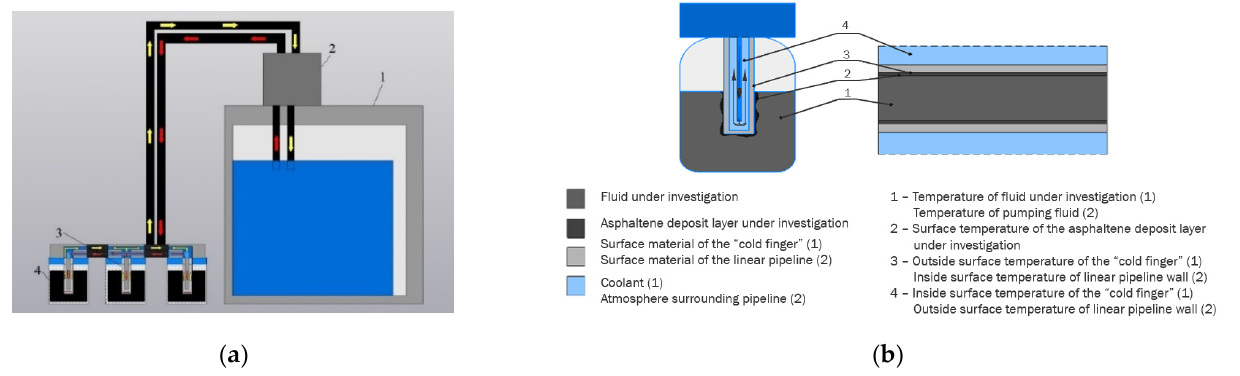
Figure 1. Laboratoryunit “ColdFinger” CF-4: ( а ) installation diagram; ( b ) inverted pipeline principle. Asphaltene–resin oils of oil fields «X» and «Y» (Perm krai) were used for preparing water–oil mixtures. Characteristics of the oils are given in Table 1.